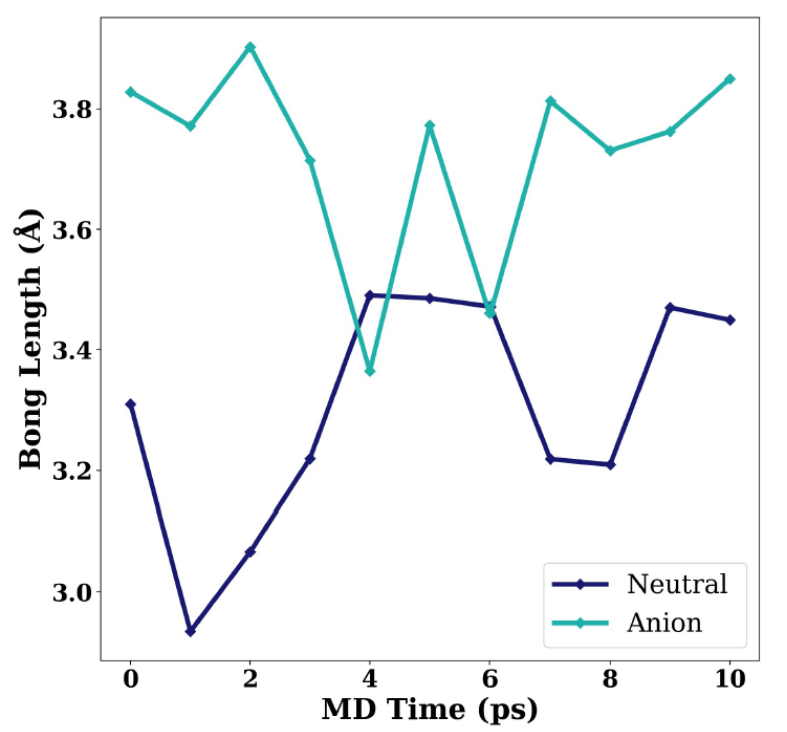
− ( 1a ) at 298 K in 10 ps ab 1n ) and CAl 4 Mg ( 4 Mg